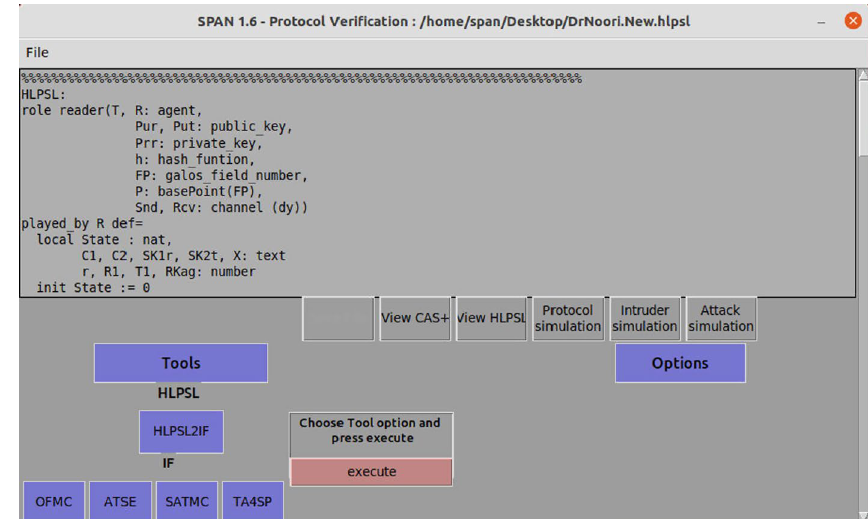
Fig. 8 Entered codes into the AVISPA software